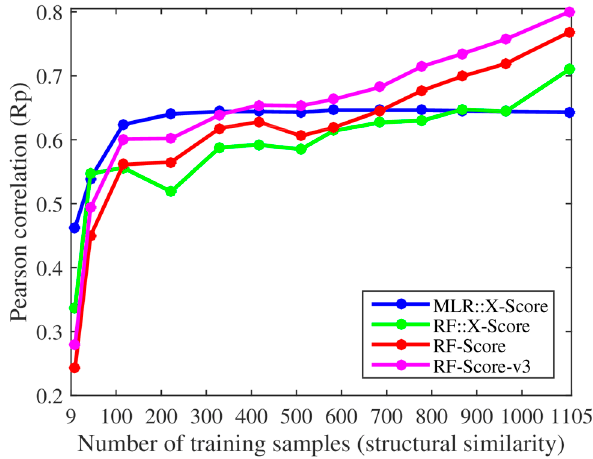
Figure 1. Test set performance of scoring functions (SFs) trained with nested datasets at different protein structural similarity cutoffs. Each of the four SFs (see legend at the right bottom) was trained with 13 nested datasets (i.e., a larger dataset includes all the complexes from the smaller datasets), leading to 13 implementations of each SF. This method to generate datasets was introduced by Li and Yang [9] to include training complexes with increasingly similar proteins to those in the test set (the smaller the data set is, the lower the applied protein structural similarity cutoff was). However, to look deeper into these questions, we incorporated two smaller training sets and also included in the comparison two additional machine-learning SFs (RF::X-Score and RF-Score-v3). For each SF implementation, the performance was calculated as the Pearson correlation between the predicted and the measured binding affinities for the 195 diverse protein–ligand complexes in the test set. We can see that X-Score’s performance levels off with as little as 116 training complexes, hence being unable to exploit the most similar complexes. By contrast, RF-Score-v3 keeps learning, outperforming X-Score with training sets larger than just 371 complexes. Note the large performance gap between machine-learning SFs and X-Score when the full 1105 complexes were all used for training. Abbreviations: RF, random forest; MLR, multiple linear regression.